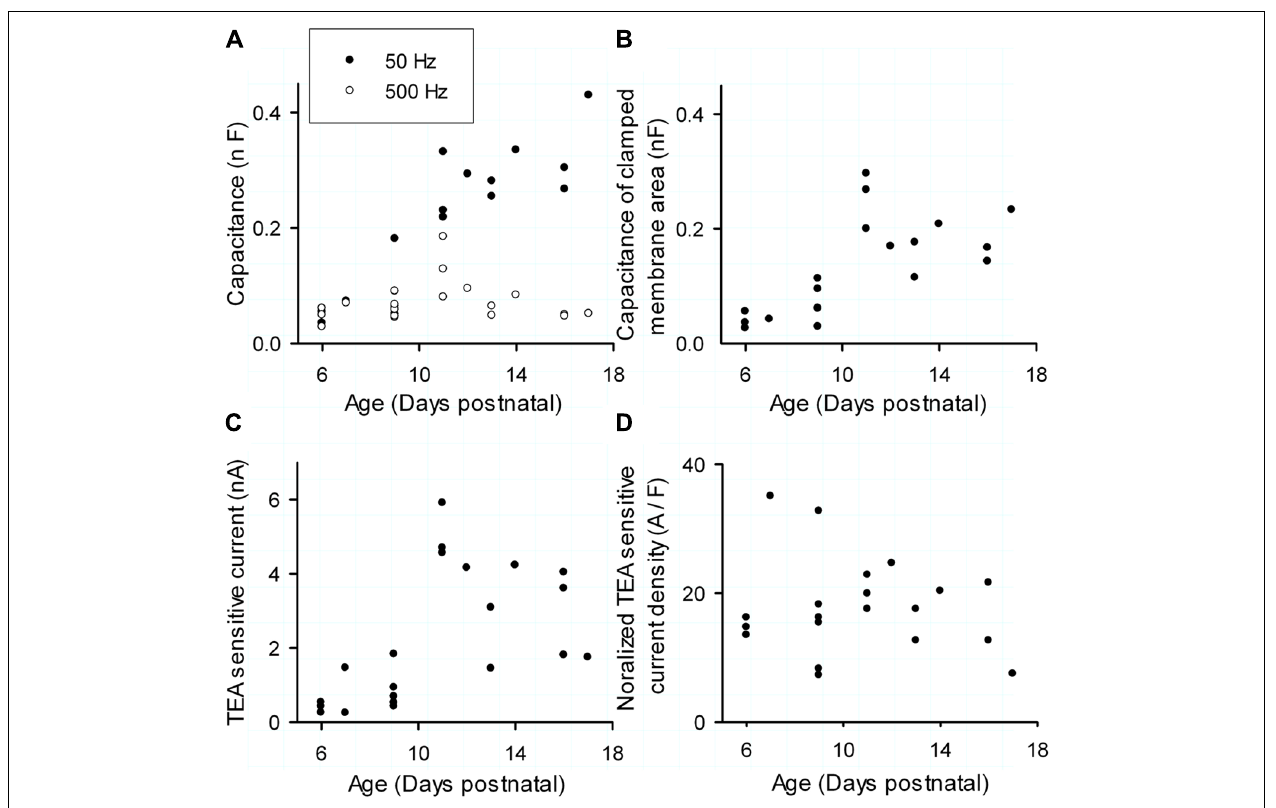
area of the cell versus postnatal age. (C) TEA- sensitive Kv3 current versus postnatal age. (D) NormalizedTEA-sensitive Kv3 current density versus age. Current density is obtained by dividing peak currents (C) by the capacitance of clamped membrane area (B)